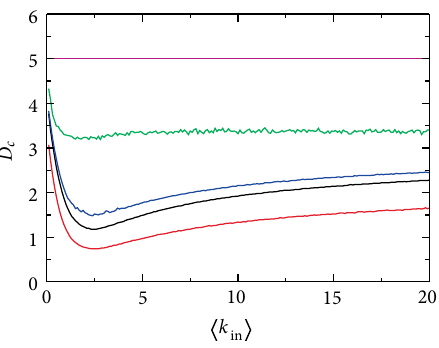
Figure 7: Market resilience 𝑅 as the function of transmitting shock level 𝐷 in external and internal link coupling scenario with ER random network (solid lines) and Scale-Free network (dashed lines) for internal links, with different weight distributions: uniform 𝐶 ∼ 𝑈 [0,10] (black), exponential 𝐶 ∼ 𝐸𝑥𝑝[5] (red) and truncated normal 𝐶 : 𝑁 (𝐶 = 5, 𝜎 = 1) (green). The initial shock is in the start- up layer. Both layers have ⟨𝑘 in ⟩ = 4 and 𝑇 = 0.5 . For the SF network, the minimum connectivity is 𝑘 min = 2 , the maximum connectivity 𝑘 max is the size of each layer, and 𝜆 = 2.65 . The results were averaged over 100 realizations.